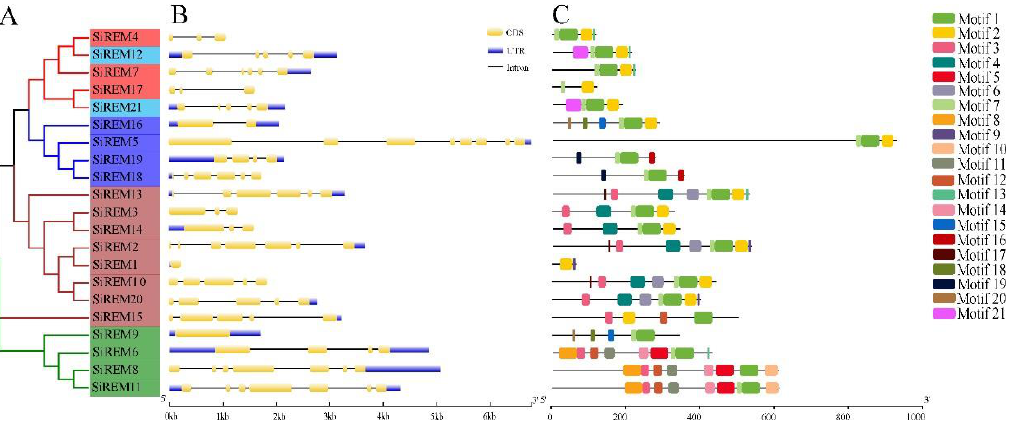
Figure 2. Phylogenetic relationships, gene structure, and conserved motifs of SiREM proteins. ( A ). Phylogenetic tree constructed based on the full-length sequences of millet remorin proteins using MEGA 7. ( B ). Exon – intron structure of millet remorin genes. Blue boxes indicate the 5′ and 3′ untranslated regions; yellow boxes represent exons; and black lines represent introns. ( C ). Motif composition of millet remorin proteins. The motifs, numbered 1 – 21, are indicated by different colored boxes.